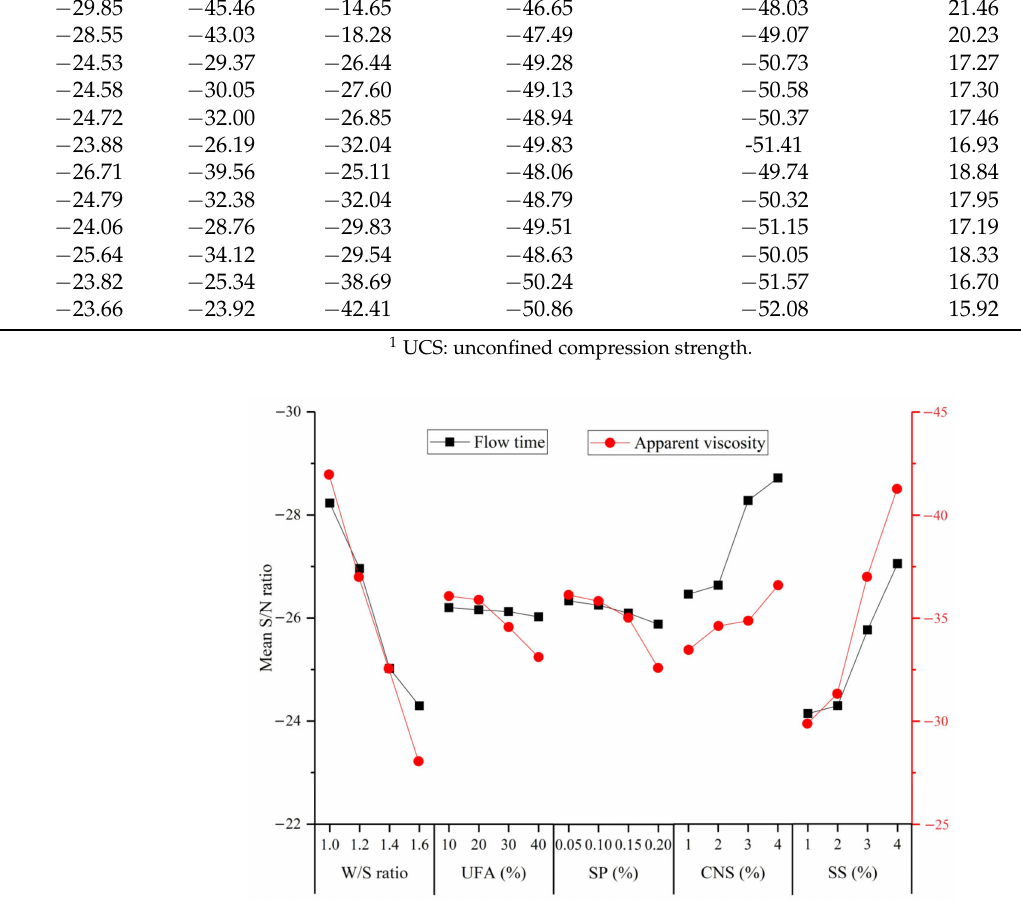
Figure 7. Mean S/N ratio values of flow time and apparent viscosity of the UC-based slurry for different